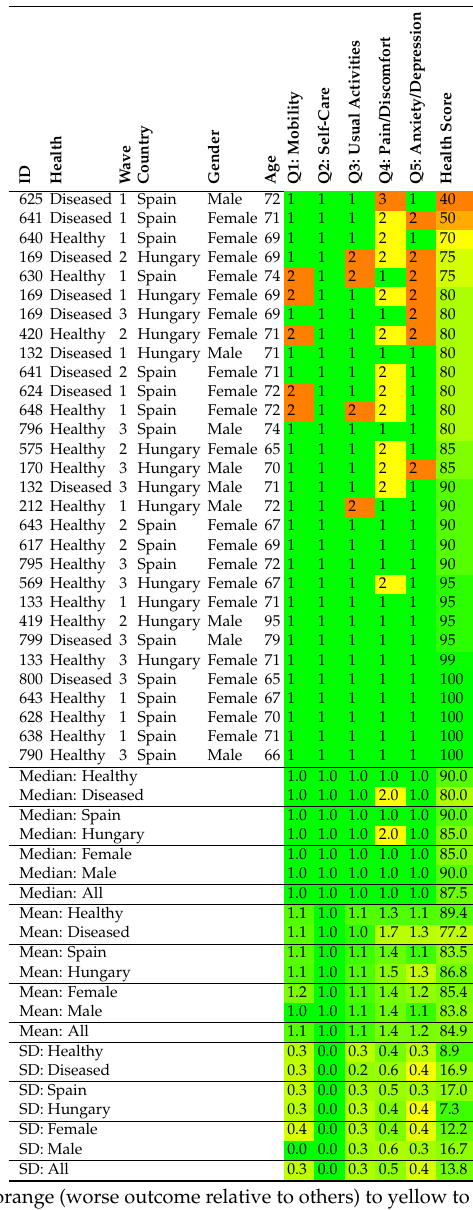
Table A10. Characteristics of PRO Health-Related Quality of Life (EQ-5D-3L).